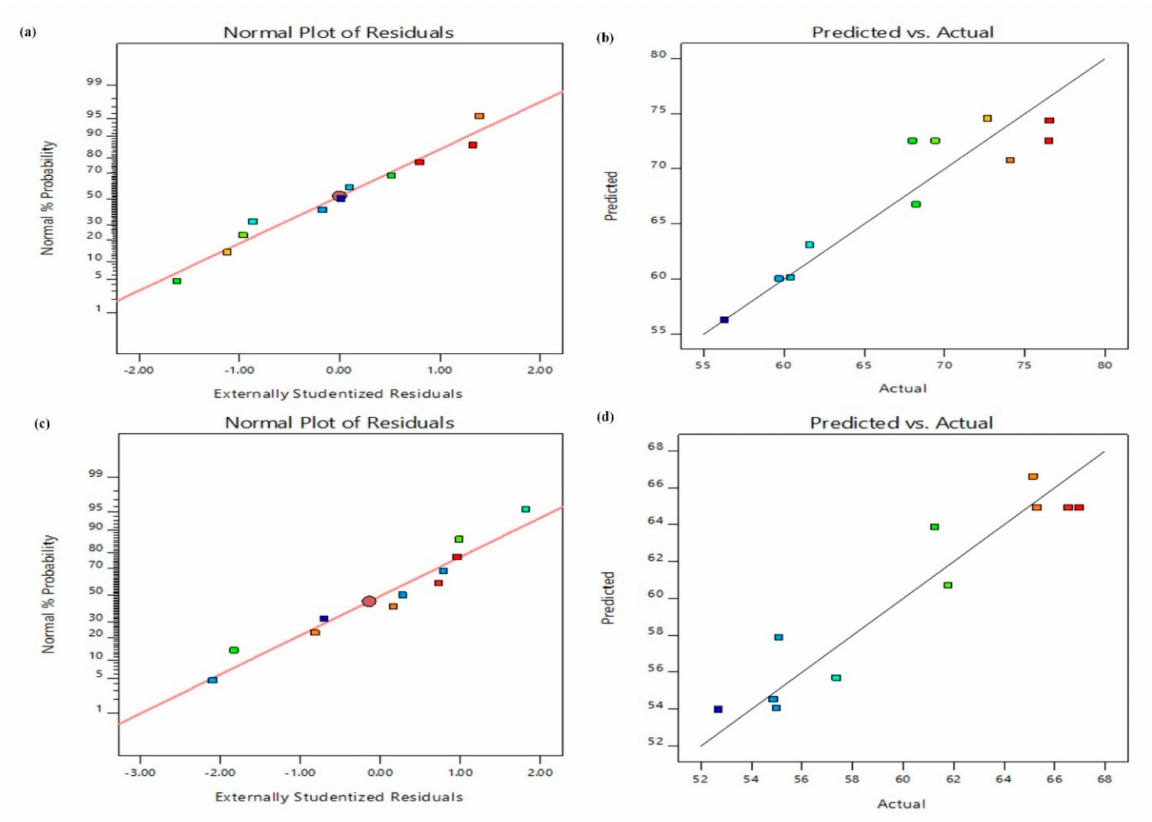
Figure 7. Plots of residuals and predicted versus actual plots of CFBS for COD ( a , b ) and color ( c , d )